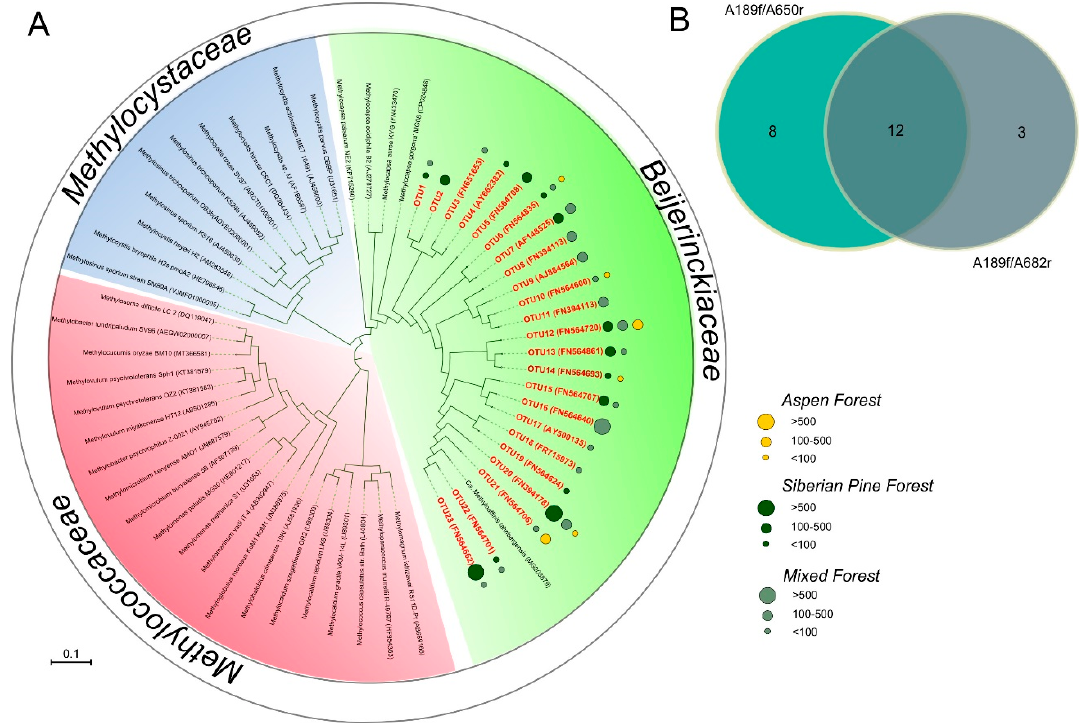
Figure 7. ( A ) pmoA -based maximum-likelihood tree showing the phylogenetic position of sequences retrieved from three different forest soils to pmoA fragments from Candidatus Methyloaffinis lahnbergensis, “ Methylocapsa gorgona ” MG08 and some representatives of the family Beijerinckiaceae ( shown in green ), Methylocystaceae ( blue ) and Methylococcaceae ( red ). Circles of different sizes reflect the number of reads corresponding to particular OTUs. The scale bar corresponds to 0.1 substitutions per nucleotide position. ( B ) The Venn diagram comparing the number of pmoA -based OTUs identified by using two different primer sets.